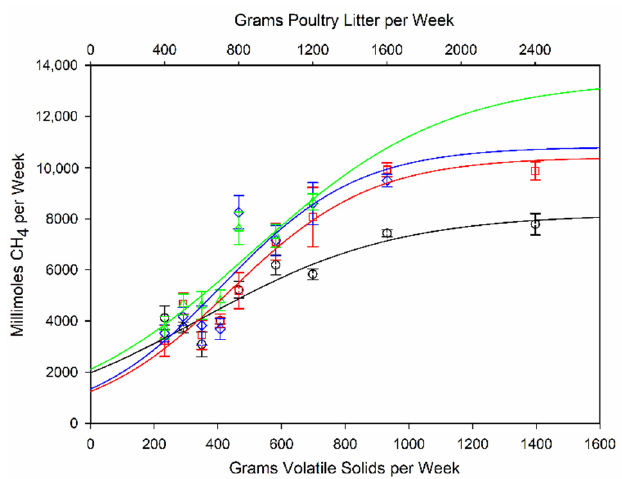
Figure 1. Millimoles of methane produced per week. Control: black circles, r 2 = 0.8808; digesters treated with sound: red squares, r 2 = 0.9422; digesters treated with sound and microaeration: blue diamonds, r 2 = 0.8702; digesters treated with microaeration: green triangles, r 2 = 0.9631. Data represent the mean ± standard error of the mean. Table 1. Biogas and digestate characteristics of poultry litter digestates.